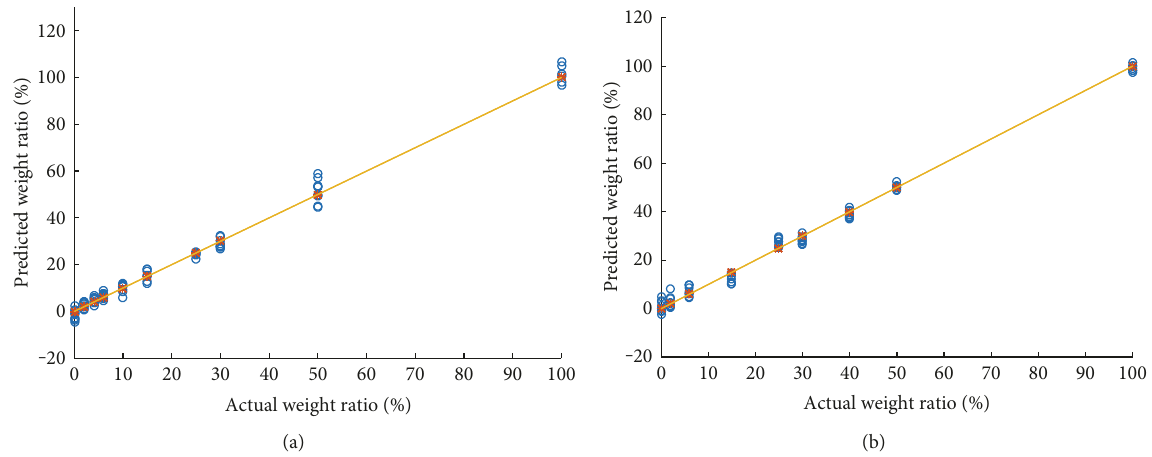
Figure 6: Performance of PLS. (a) Carbendazim and polyethylene mixture. (b) Carbendazim and rice powder